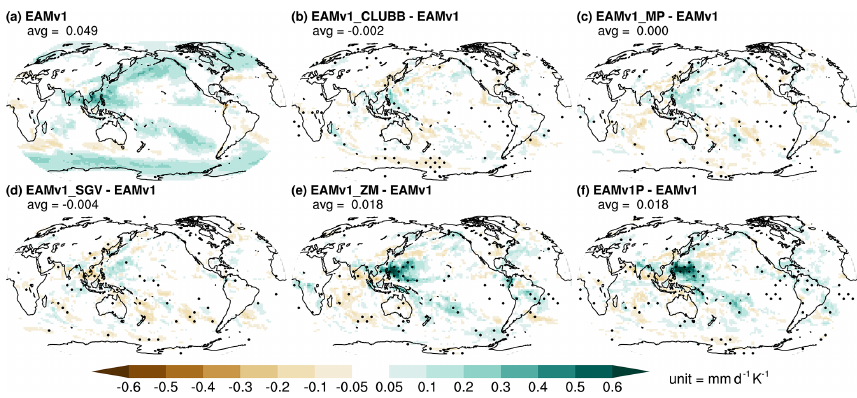
Figure 21. The change in large-scale precipitation rate induced by surface